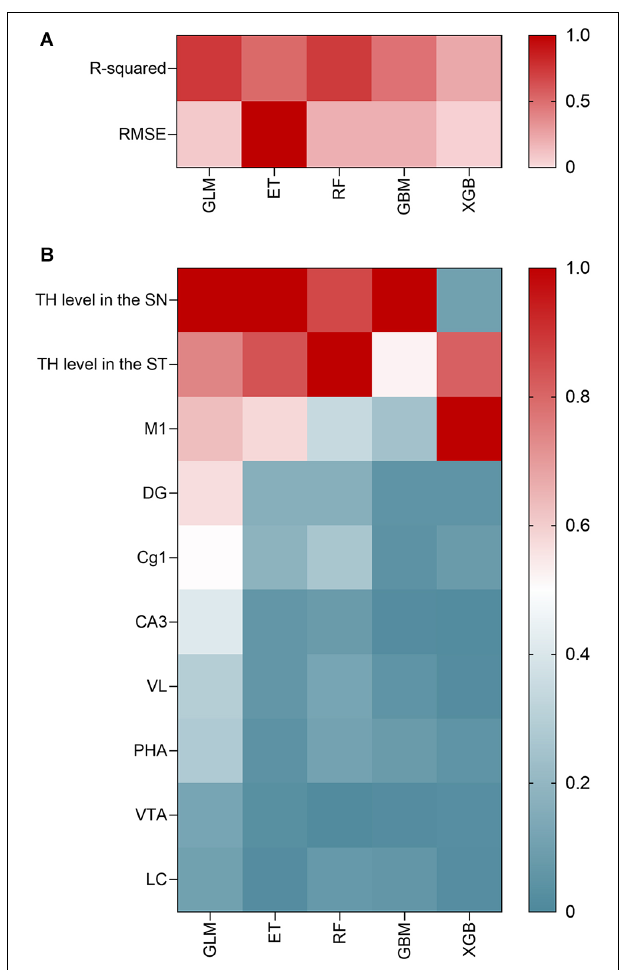
FIGURE 4 | Correlation analysis of machine learning model development and hub areas identified through it. (A) Prediction accuracy of the five ML models in terms of the RMSE. (B) Important variables through GLM model